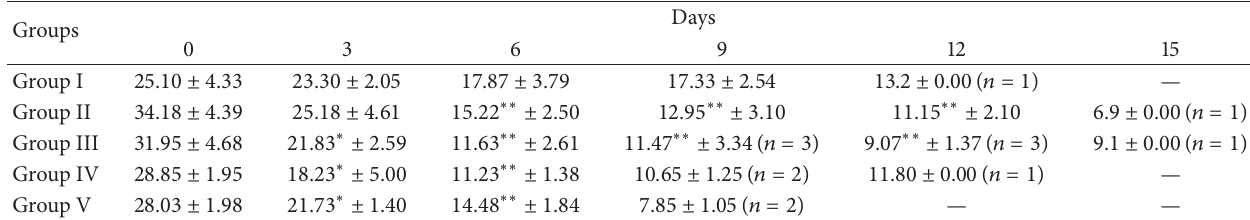
Table 6: Total leukocyte counts ( × 10 9 /L) in different groups at various observation intervals (mean ± S.E.).